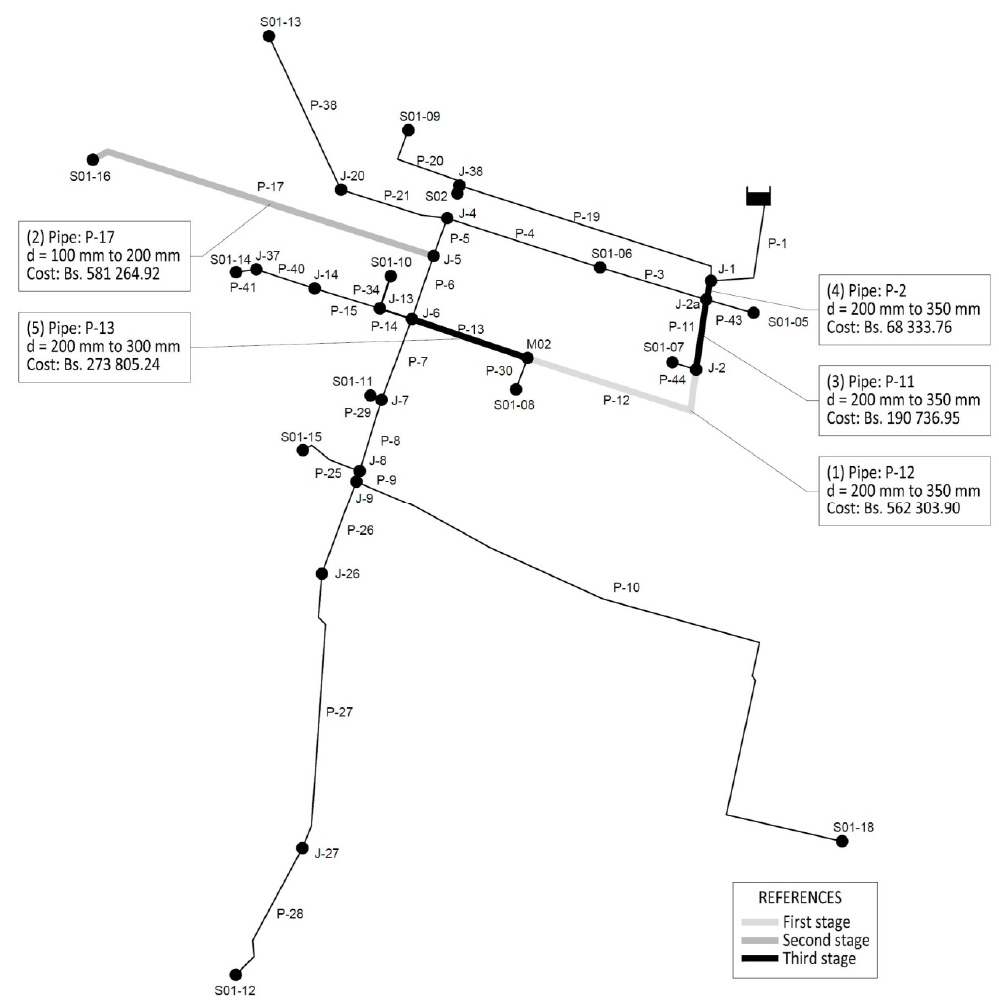
Figure 13. Stages of investment.